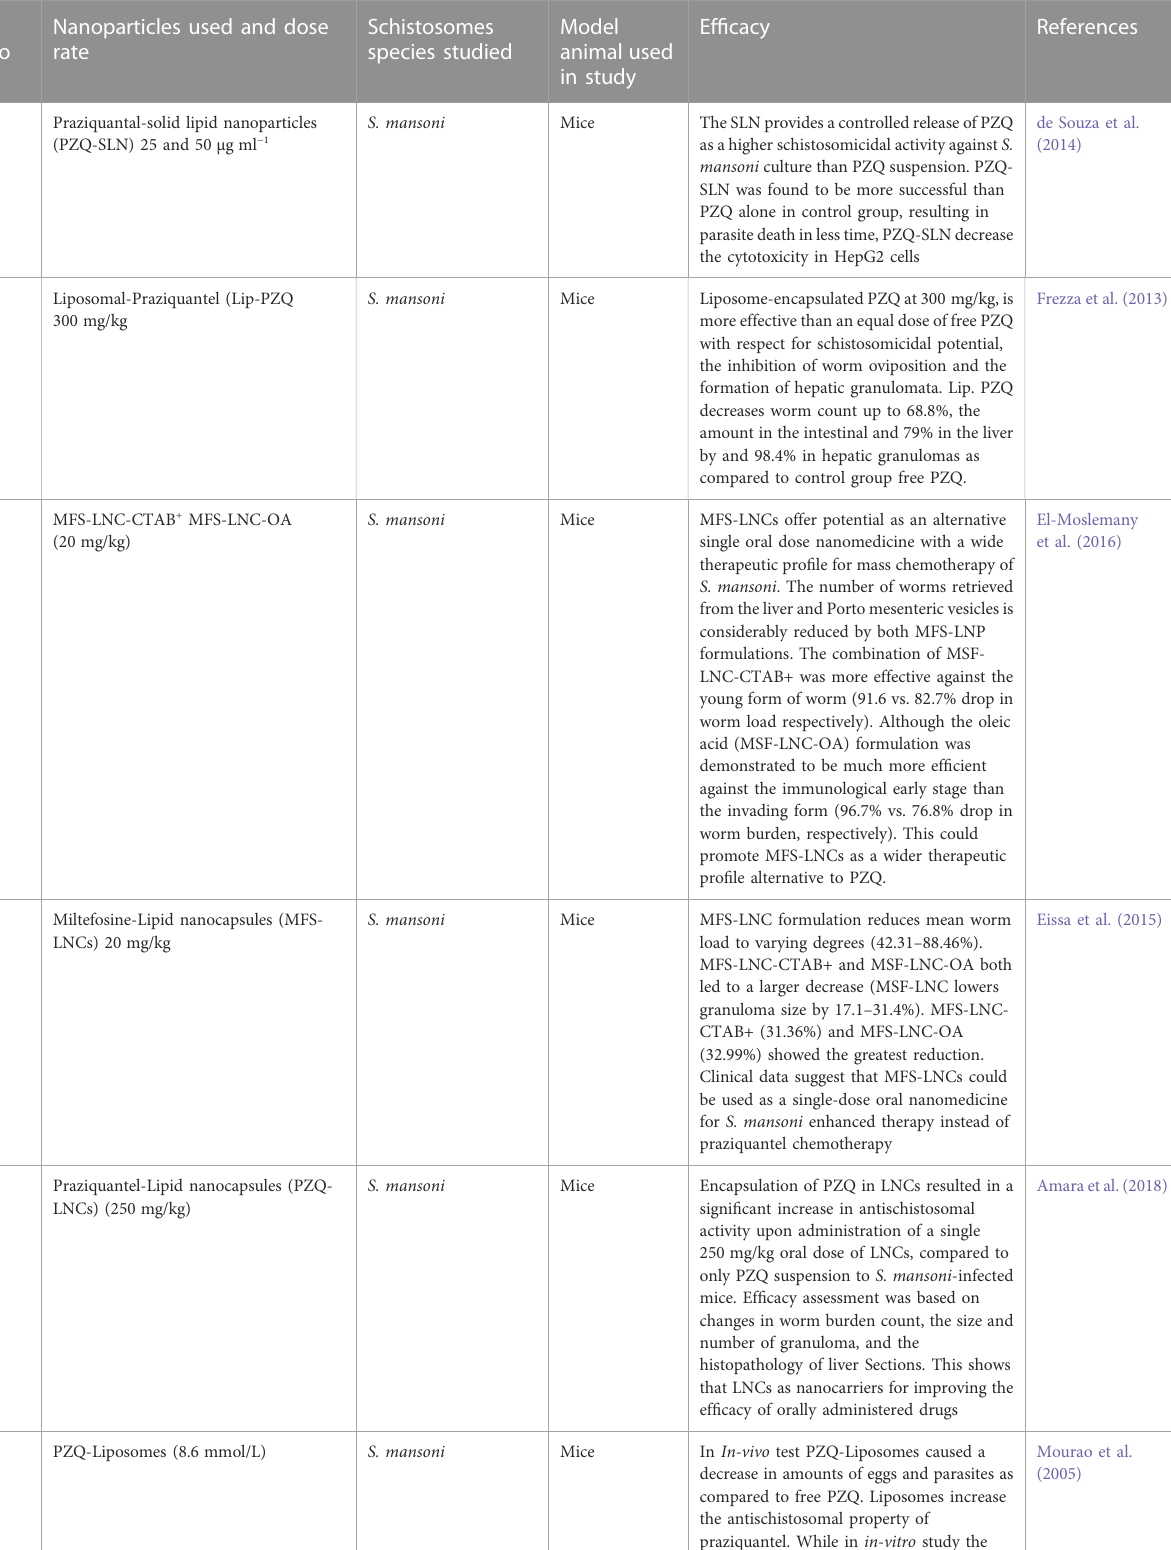
TABLE 1 List of different Nano-delivery systems used to improve the treatment ef fi cacy of drug against schistosomal infections. S.